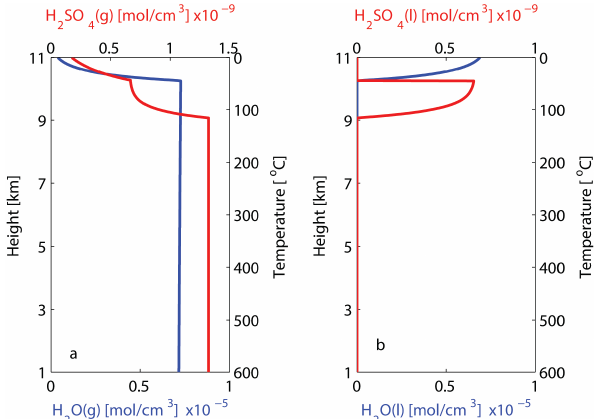
Figure 3. Vertical profile of the water (blue line) and sulfuric acid (red line) concentrations in the (a) gas and (b) aqueous phases in the eruption plume. Please note the significant differences between H 2 O and H 2 SO 4 concentration. Vertical axes on left and right show the elevation and the plume temperature, respectively.